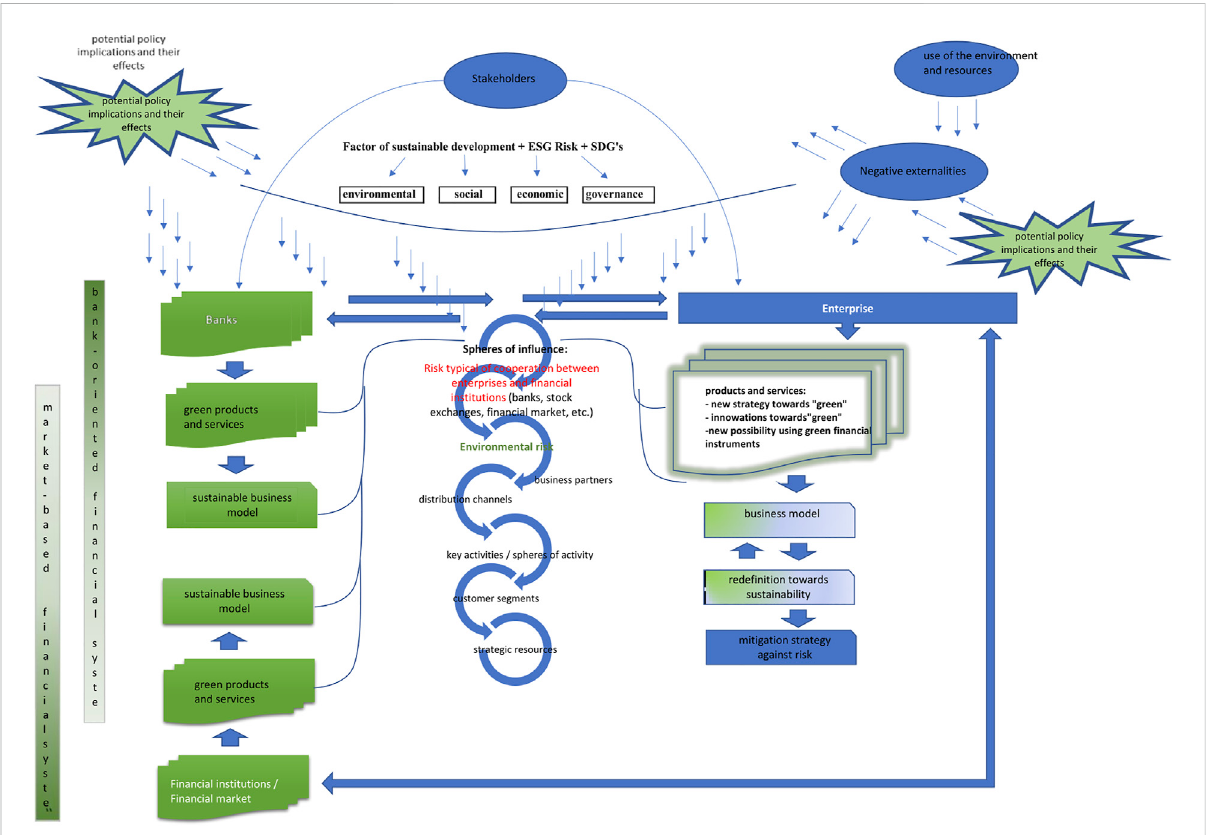
Mutual interactionsbetweenthe fi nancialinstitutionsandtheenterpriseintermscooperation towardssustainability,mitigation riskandchange the business models, Source: own